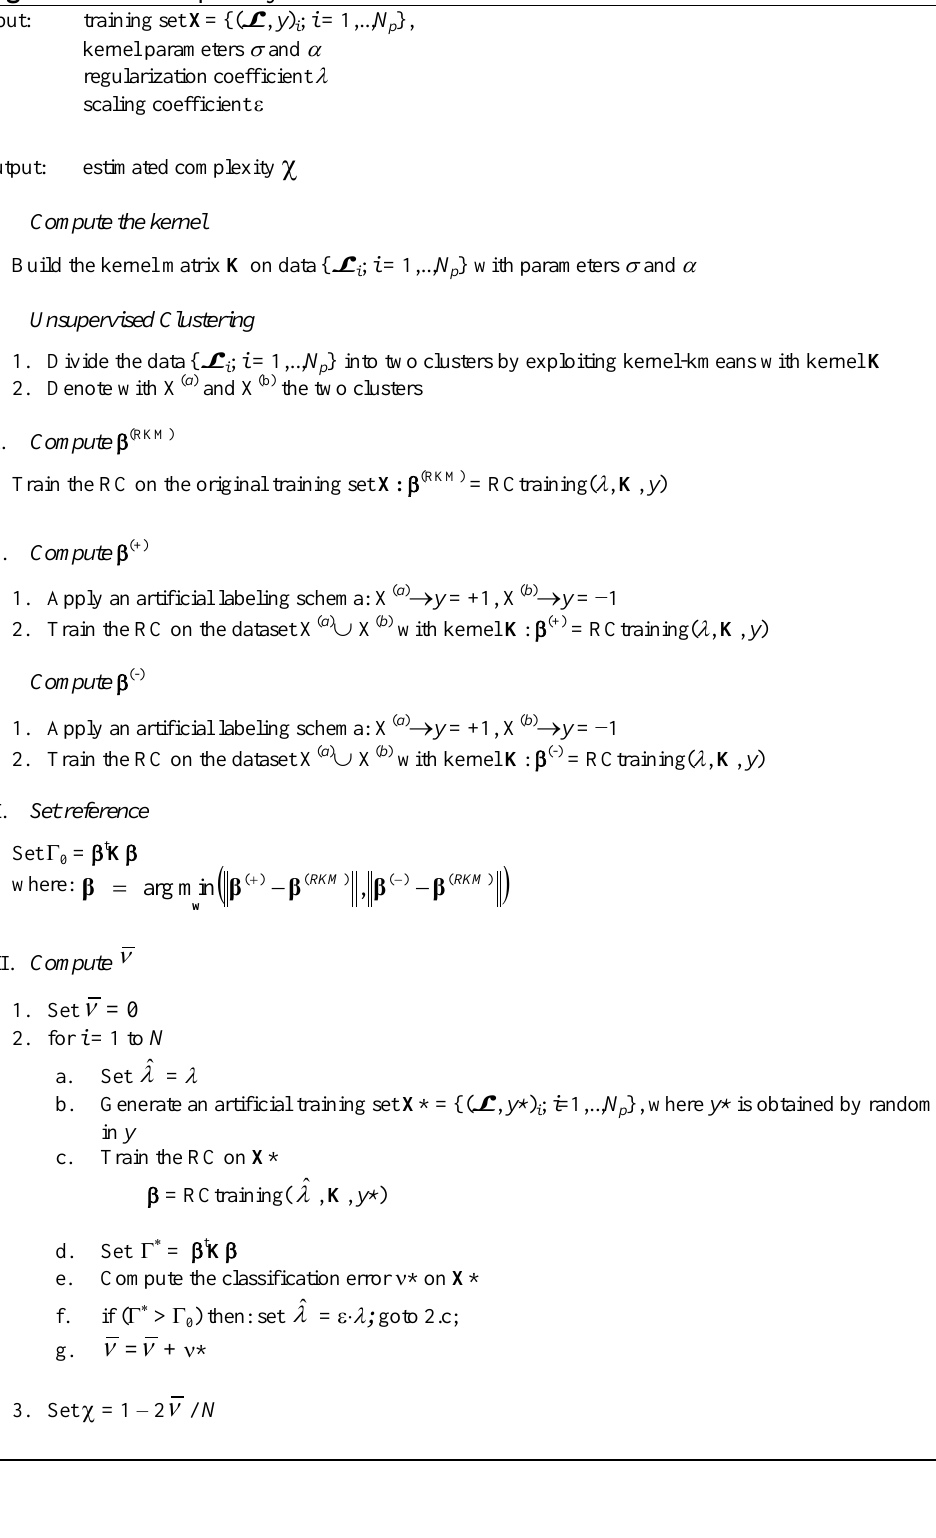
Algorithm 1 Complexity